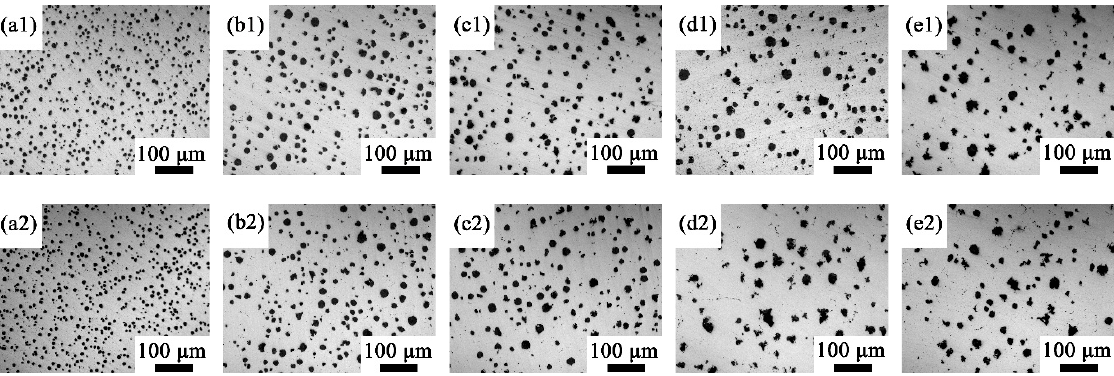
Figure 2. Microstructures of unetched as-cast specimens: ( a1 ) AC 60, ( b1 ) AC 75, ( c1 ) AC 95, ( d1 ) AC 120, ( e1 ) AC 150 and austempered specimens ( a2 ) ADI 60, ( b2 ) DI 75, ( c2 ) ADI 95, ( d2 ) ADI 120, ( e2 ) ADI 150. Table 1. The nodular graphite diameter in cast and ADI states. The Nodular Diameter/ μ m